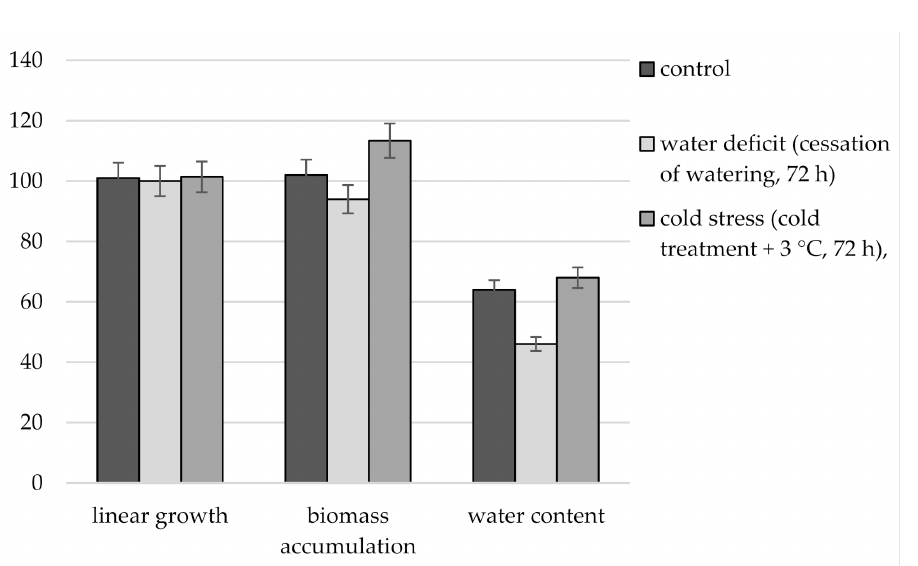
Figure 1. Changes in growth parameters, biomass accumulation and water content of R. semenowii under stress